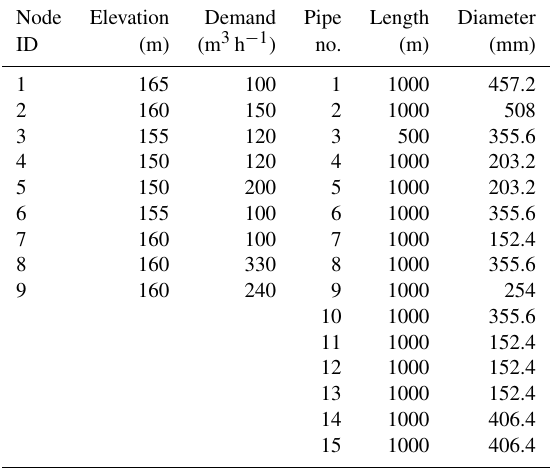
Table 5. Nodal and pipe properties of multisource pumped network. Node